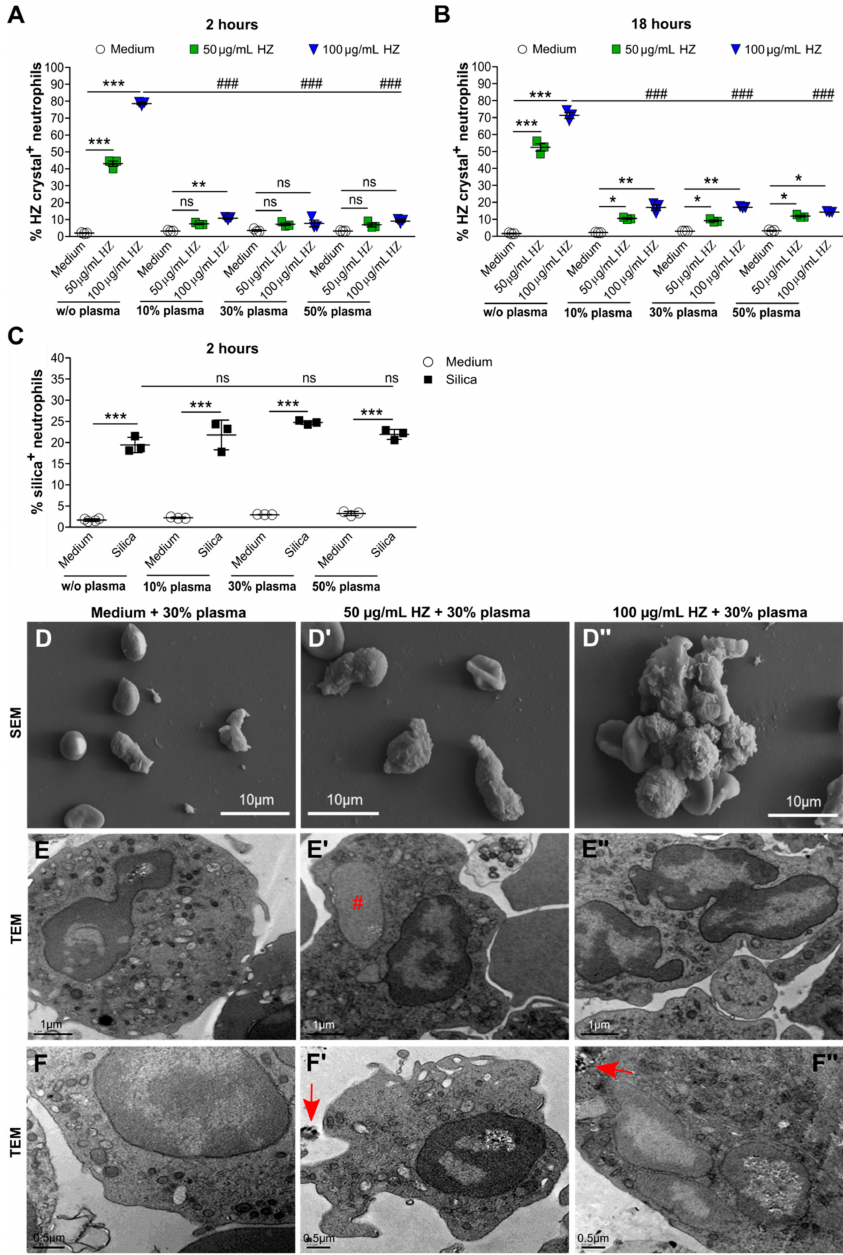
Figure 3. Human plasma impaired hemozoin but not silica uptake in neutrophils. Human neutrophils were isolated from healthy volunteers and cultured in the presence or absence of HZ (50 and 100 µ g / mL) or with di ff erent amounts of human plasma for 2 and 18 h. ( A , B ) Percentage of HZ crystal + neutrophils was determined using flow cytometry after 2 h ( A ) and 18 h ( B ) ( n = 3 donors). ( C ) Neutrophils stimulated with or without silica crystals and / or human plasma for 2 h. The percentage of neutrophils that had taken up silica was determined by flow cytometry ( n = 3 donors). Data are mean ± SD and representative of two independent experiments. * p < 0.05; ** p < 0.01; *** p < 0.001; ns, not significant using two-way ANOVA. w / o indicates without. ( D ) Scanning electron microscopy (SEM) images of neutrophils treated with 30% plasma and / or HZ of 2 h. ( E , F ) Transmission electron microscopy (TEM) images of neutrophils treated with 30% serum and / or HZ of 2 h. TEM images showed HZ-activated neutrophils with normal morphology and occasionally loss of nuclear heterochromatin ( E’ , indicated by #), and extracellular and intracellular HZ ( F’ , F” , indicated by red arrows). ### p <